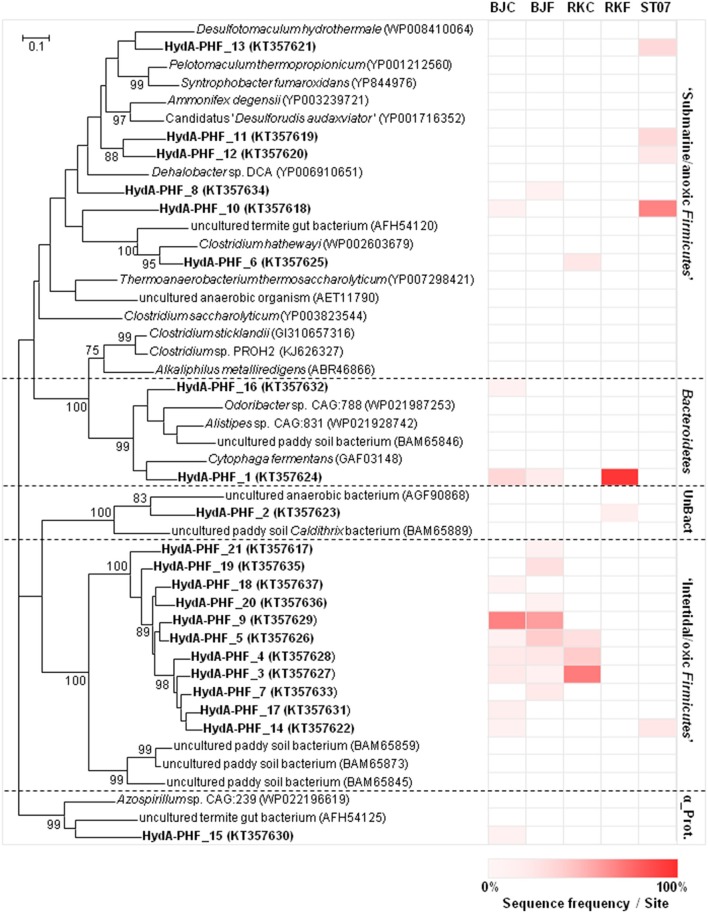
Maximum-likelihood phylogenetic tree of [Fe-Fe]-hydrogenase sequences obtained from intertidal and submarine PHF sites. Protein HydA sequences (188 amino acids) were obtained after translation of hydA gene sequences (obtained by cloning and Sanger sequencing) for 3 PHF hydrothermal sites: “Bain des Japonais” (BdJ), “Rivière des Kaoris” (RK), and “Aiguille de Prony” (ST07). The suffix “C” in sample names corresponds to “chimney” and the suffix “F” corresponds to “fluid”. The [FeFe]-hydrogenase sequences from PHF samples are marked in bold. Each OTU is represented by one representative sequence (at ≥80% similarity level). Percentage of OTU with respect to the total number of retrieved sequences in each PHF site is indicated by different levels of red from 0% (white) to 100% (red). Genbank accession numbers (in brackets) were obtained from the protein sequence database. Bootstrap values < 70% are not shown. The scale bar indicates 0.1% sequence divergence. UnBact and α_Prot stand for unclassified Bacteria and Alphaproteobacteria, respectively.